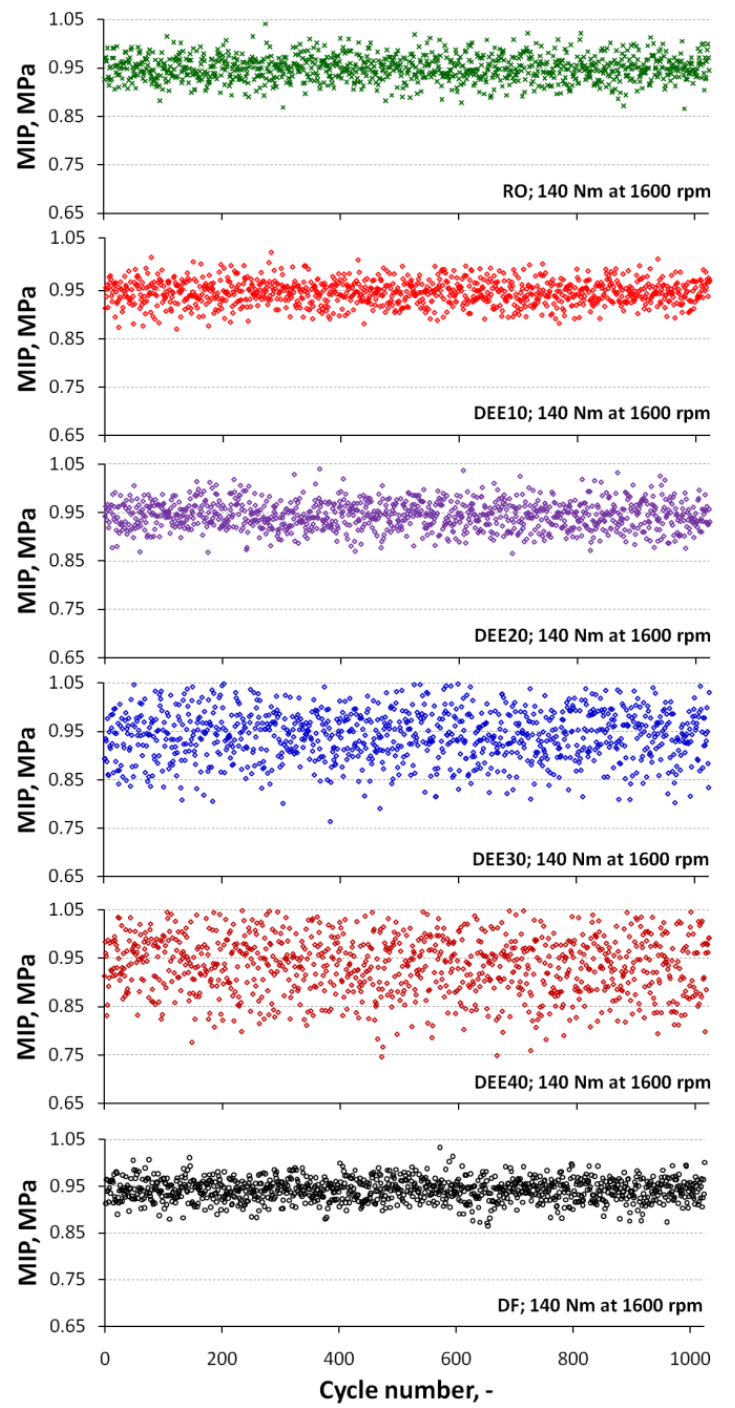
Figure 7. MIP calculated for 1024 consecutive cycles recorded for the AD3.152 engine fueled with tested fuels, operated with 140 Nm at 1600 rpm.